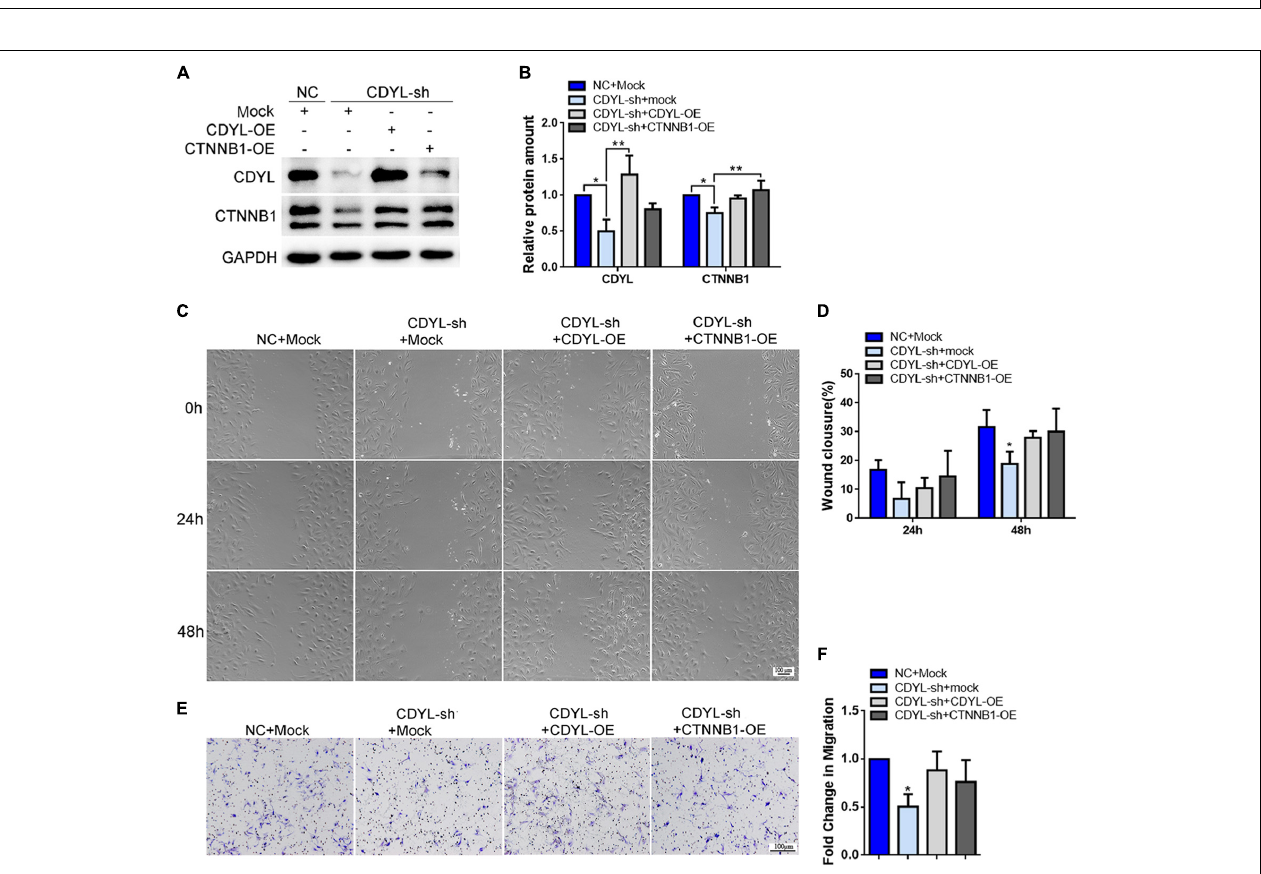
FIGURE 9 | Effects of CDYL knockdown/over-expression on the expression of CTNNB1 and cell migration in primary endometrial stromal cells. (A,B) Effects of CDYL on CTNNB1 expression level in ESCs by Western blot analysis. Effects of CDYL on cell migration in ESCs by wound-healing assay (C,D) and transwell migration assay (E,F) . Bar = 100 µ m. N = 3. All data are presented as mean ± SD. * P < 0.05; ** P < 0.01.